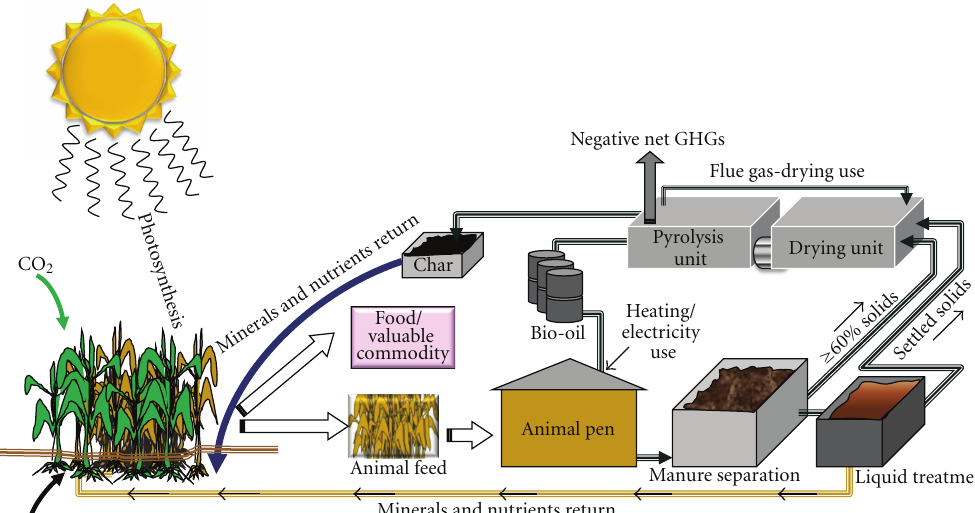
Figure 9: Possible farm practice of biomass